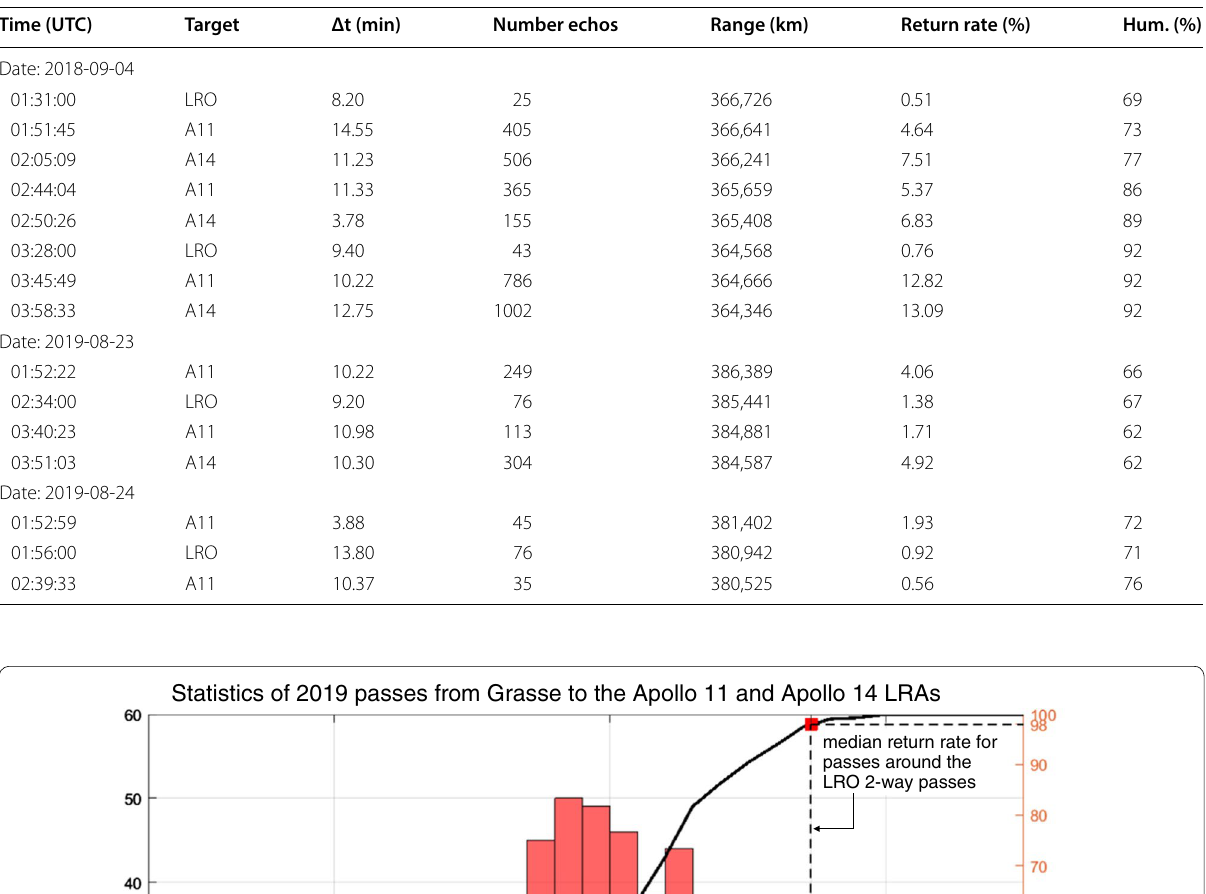
Table 3 Statistics of the two‑way LLR passes obtained by Grasse during and immediately surrounding the LRO ranging experimental periods